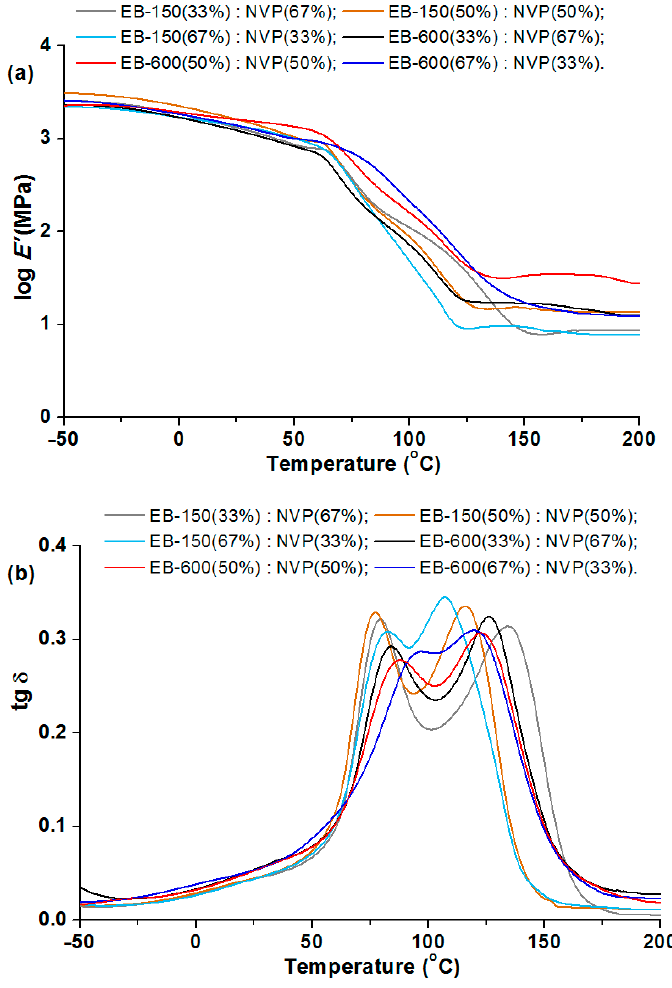
Figure 13. DMA analysis of copolymers: ( a ) storage modulus and ( b ) tangent delta in the function of temperature. Table 7. Data of DMA measurements of blends with 5 wt.% of